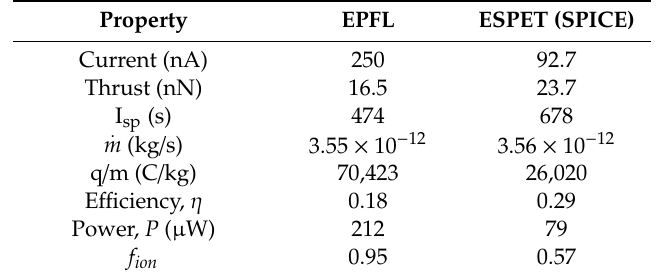
Table 6. Experiment (Ecole Polytechnique Federale de Lausanne, EPFL) and ESPET comparison for cone-jet only model mode (emitter average).